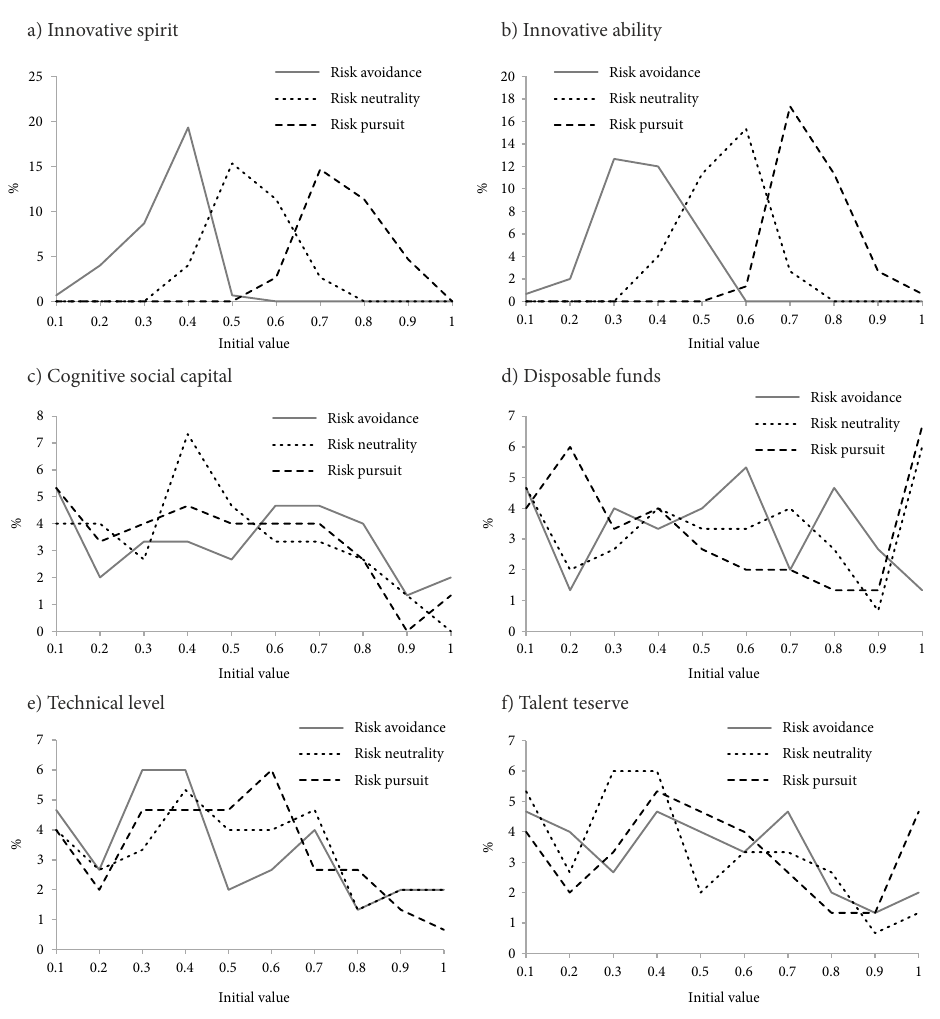
Figure 3. Initialization settings of entrepreneurs’ agent attributes in the new